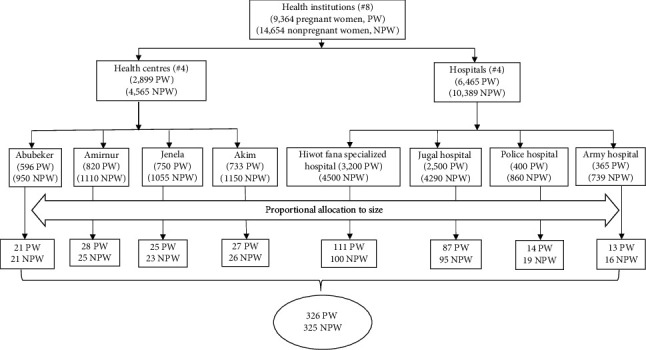
Sampling procedure for pregnant and nonpregnant women in public health facilities, Harar, Eastern Ethiopia, from February to December 2017.